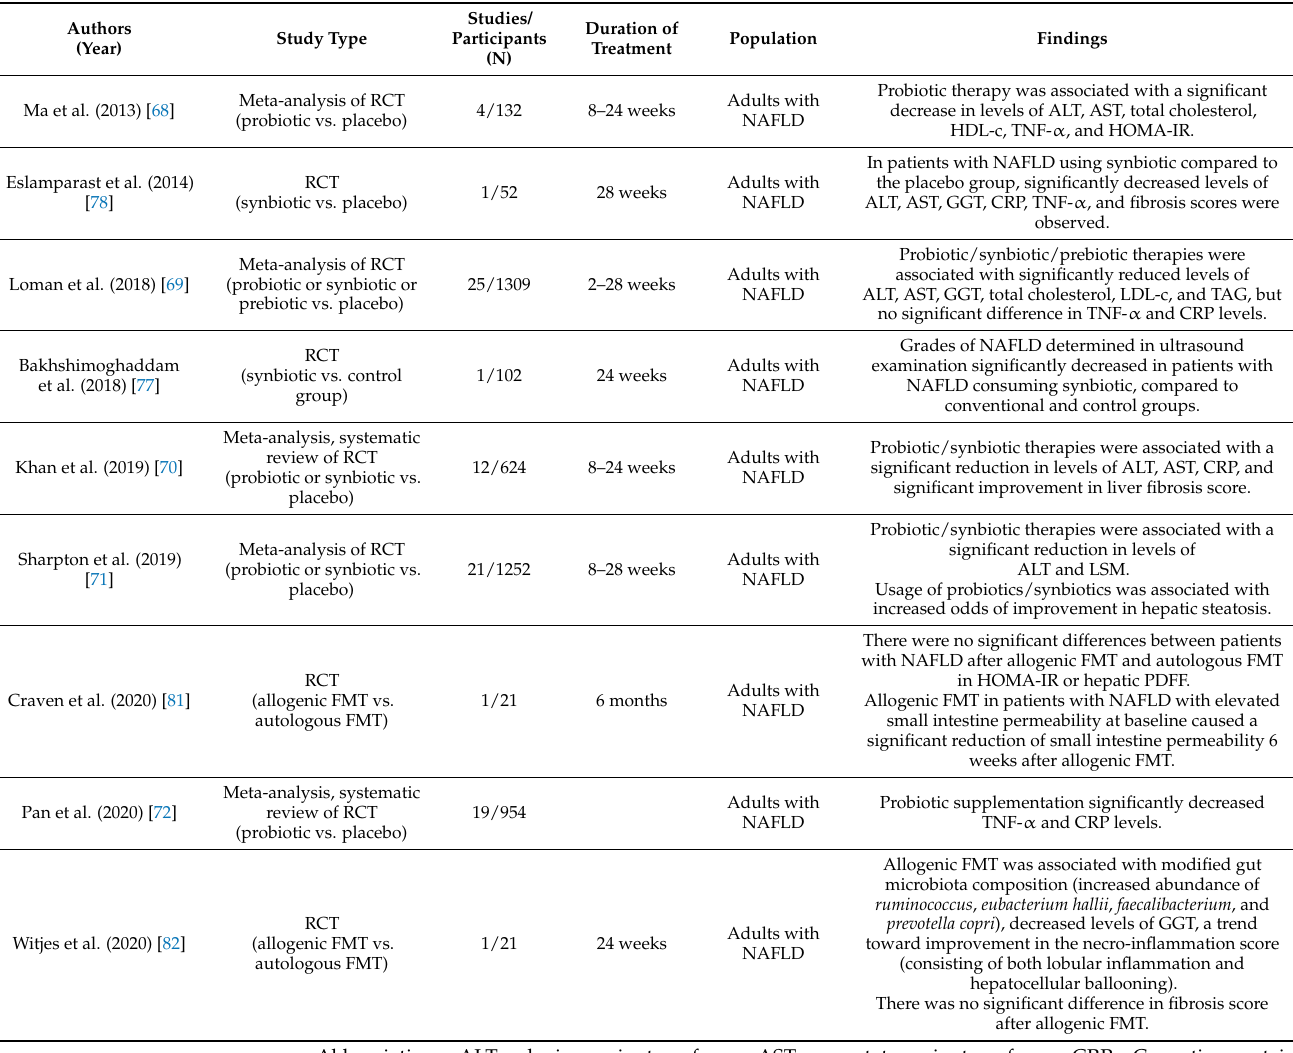
Table 3. Treatment of NAFLD with microbiome